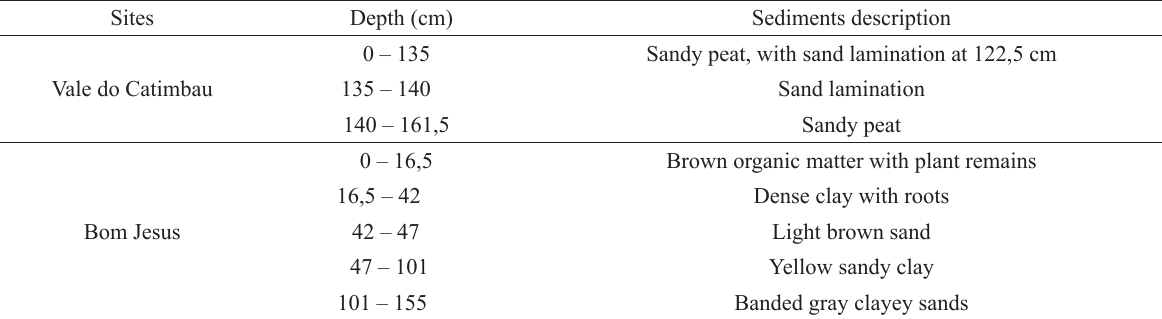
Lithology of the Vale do Catimbau peat and Bom Jesus sequence.